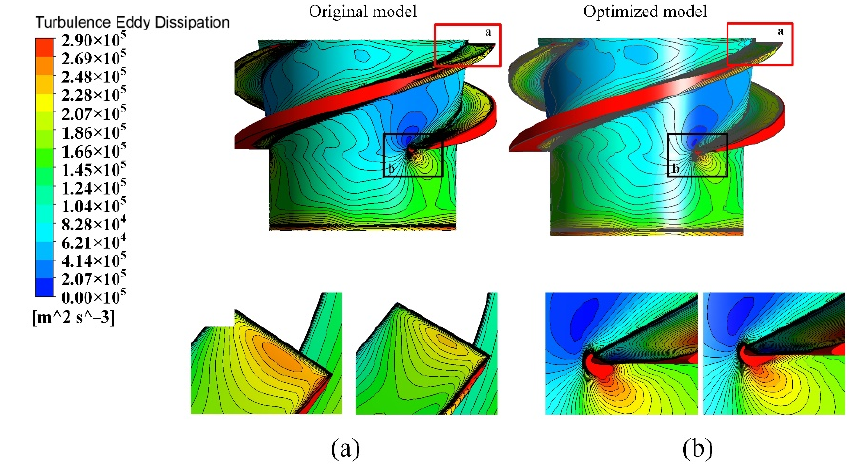
Figure 15. ( a , b ) Distribution of turbulent energy dissipation rate under the water condition.